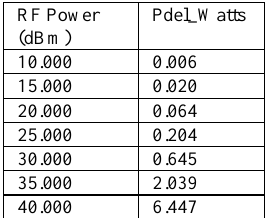
Table 2: Power delivered to